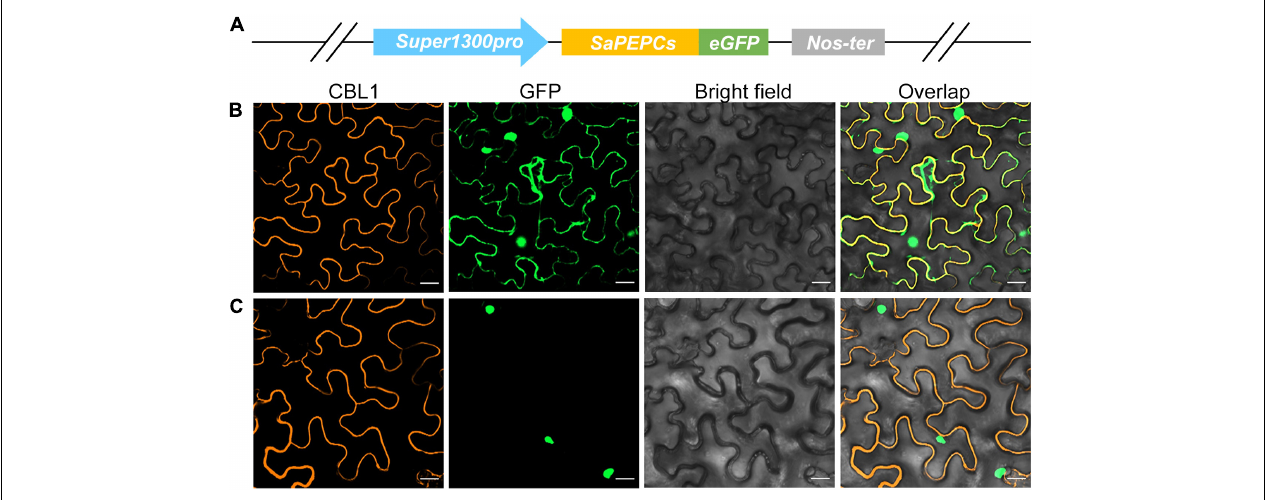
FIGURE 3 | Subcellular localization of two types of SaPEPC in tobacco epidermal cells. (A) Schematic diagram of vector construction; (B) SaPEPC-1; (C) SaPEPC-2. CBL1, calcineurin B-like protein 1, membrane marker control; GFP, green fluorescent protein. Bar = 20 µ